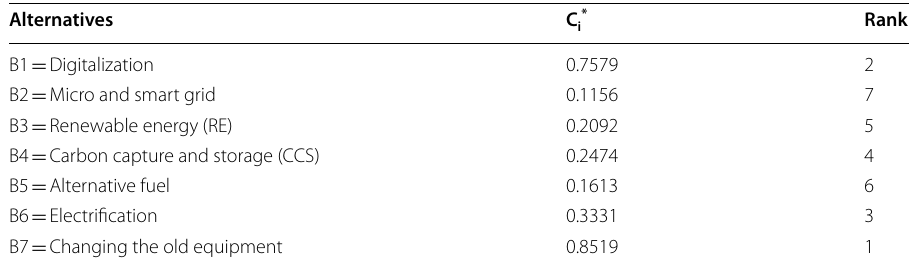
Table 21 Top Alternatives in Technology and innovation criterion